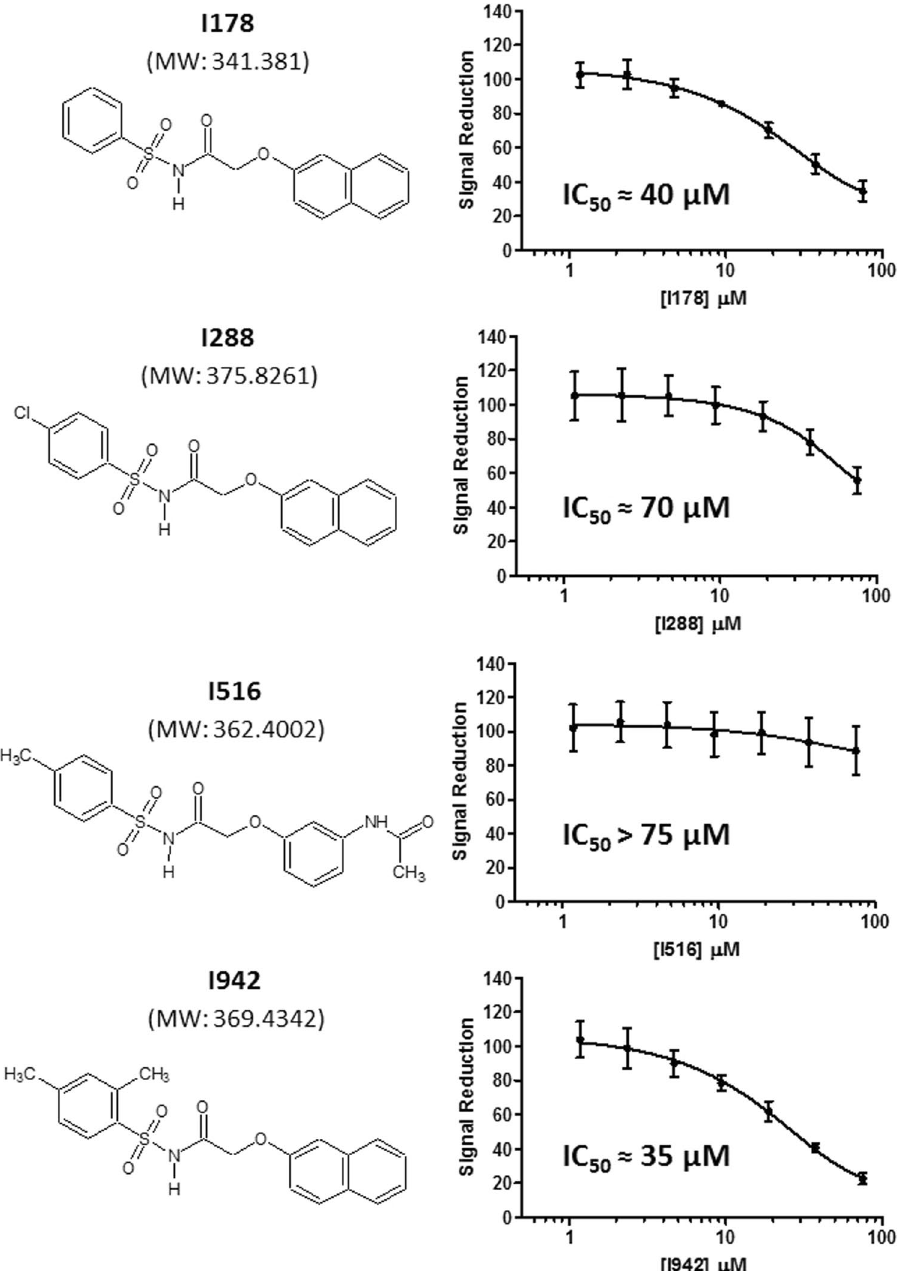
Figure 3. Dose Response Testing of Hits against EPAC1-CNB. The three hit compounds isolated from the Bioascent libraries (structures and molecular weights are shown on the left ) were tested in a 7-point dose response format (75 µ M top concentration, 1 in 2 serial dilution, n = 6 on one plate) alongside a non-binding compound (I516) in the EPAC1-CNB, 8-NBD-cAMP binding assay with final DMSO concentration of 0.75%.